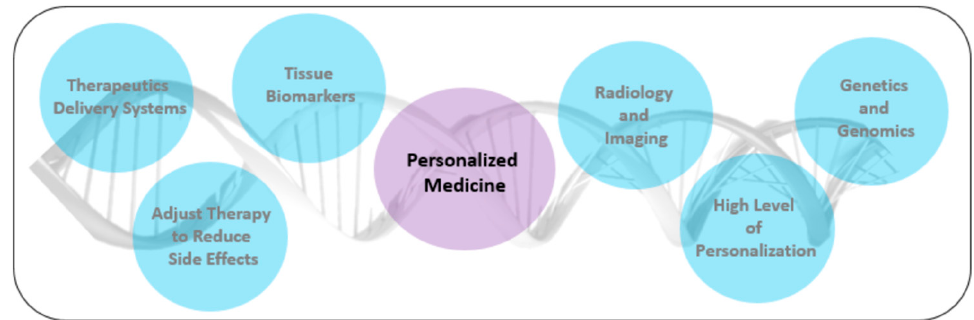
Figure 1. Scheme of personalized medical treatment.